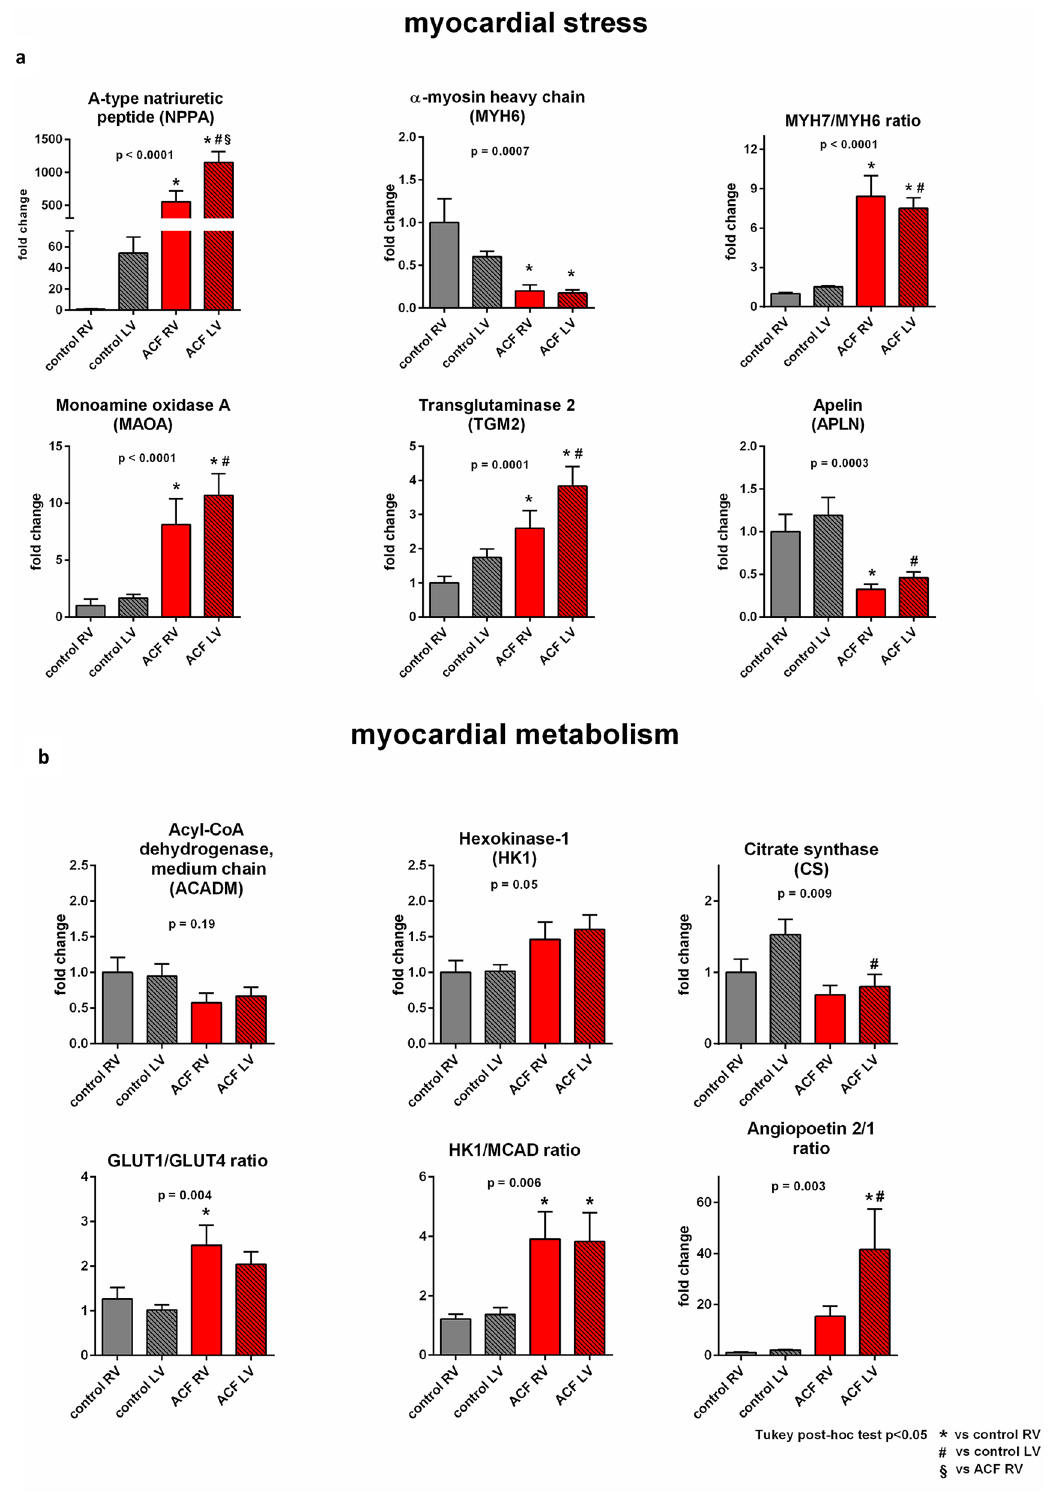
Figure 2. Gene mRNA expression analysis of cardiac markers of stress and metabolism. Gene mRNA expression analysis of selected genes that reflect ( a ) myocardial stress, ( b ) substrate metabolism and bioenergetics. Data are presented as means ± SEM. Changes normalized to control RV. N = 12 in each group. p value: ANOVA, and Tukey post-hoc